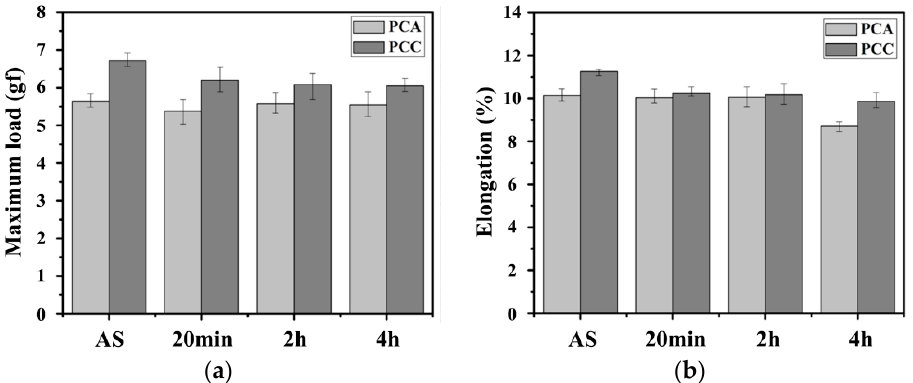
Figure 2. Tensile properties of PCA and PCC wires after sulfidation: ( a ) Maximum load, and ( b ) elongation.